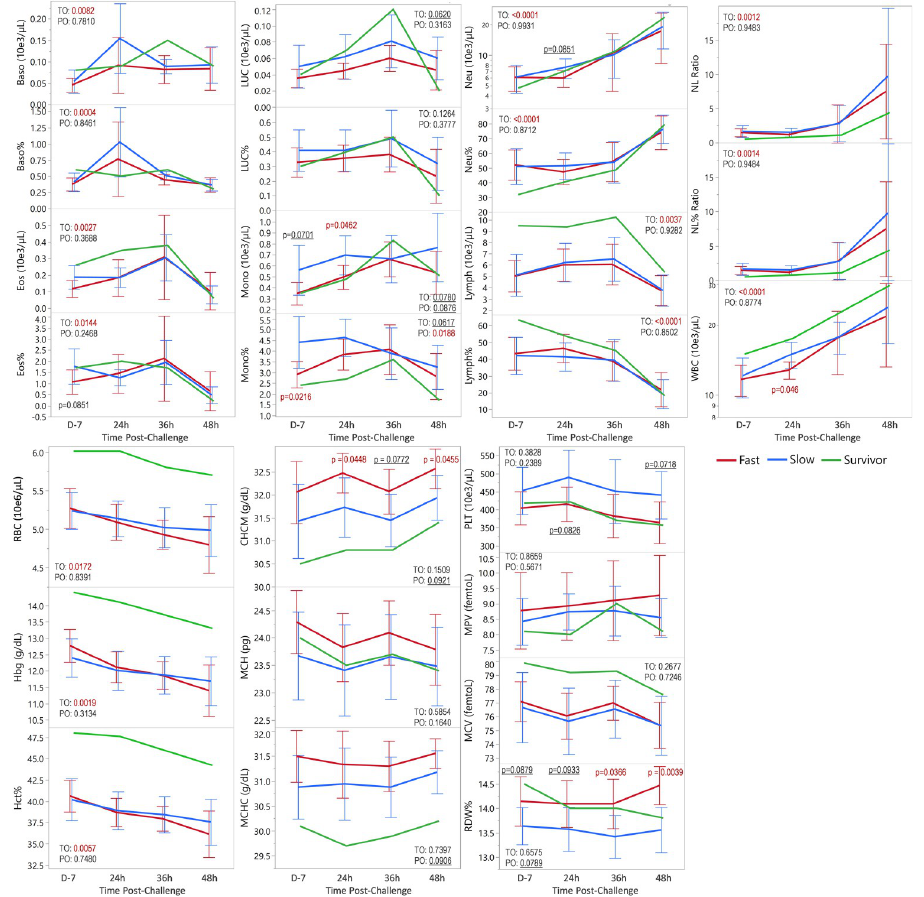
Fig 6. Early hematology during inhalation anthrax. Means and 95% confidence intervals graphed from day -7 (7 days pre-challenge) to 48 hours(h) post-challenge for fast progression (n = 11, n = 9 at 48 h), slow progression (n = 11), and survivor (n = 1). Differences between fast and slow progression at individual time points were determined by one- way ANOVA. P-values � 0.10 were included in black font and p-values � 0.05 in red font. All means, confidence intervals and p-values are included in Table 6. JMP fit model was used to test the effect of hematology with time (day -7, 24 h, 36 h and 48 h) and progression (fast vs slow). P-value for time overall (TO) and progression overall (PO) is given. Basophils (Baso), eosinophils (Eos) large unstained cells (LUC), monocytes (Mono), neutrophils (Neu), lymphocytes (Lymph), neutrophil lymphocyte ratio (NL Ratio), white blood cells (WBC), red blood cells (RBC), hemoglobin (Hgb), hematocrit (Hct), corpuscular hemoglobin concentration mean (CHCM), mean corpuscular hemoglobin (MCH), mean corpuscular hemoglobin concentration (MCHC), platelets (PLT), mean platelet volume (MPV), mean corpuscular volume (MCV), red cell distribution width